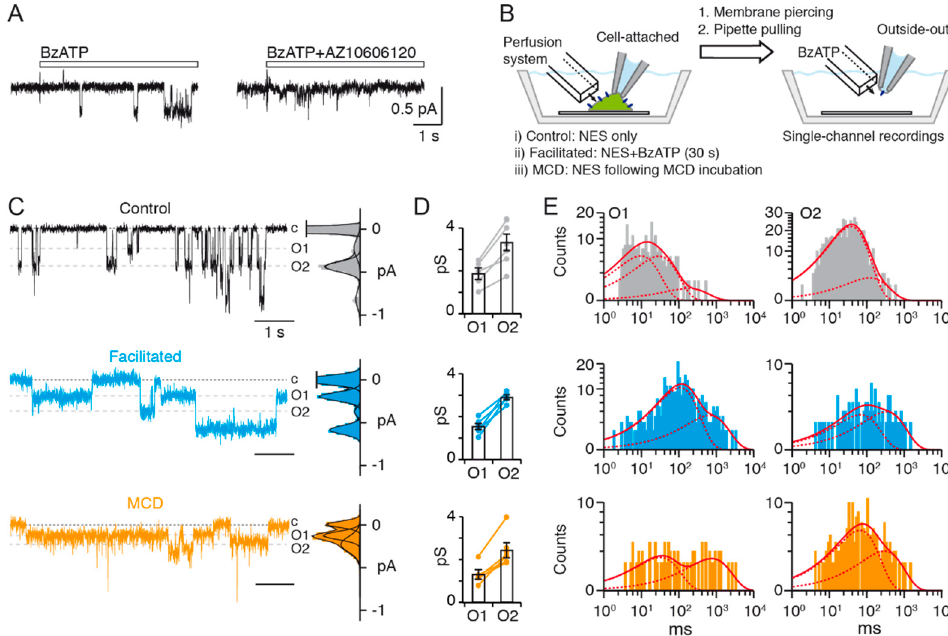
Figure 1. Current facilitation of P2X7 results in an increase of single-channel open probability. ( A ) Single-channel currents elicited by 10 µ M BzATP (duration of application indicated by the white bar) from an outside-out patch of HEK293T cell transiently transfected with rP2X7 (left) are inhibited by 1 µ M AZ10606120 when co-applied with 10 µ M BzATP (right). Traces are from the same patch and channel openings are downward deflections. ( B ) Cartoon depicting the protocol employed for establishing excised patches from cells expressing rP2X7 (blue ovals) in: (i) control conditions, (ii) facilitated conditions (10 µ M BzATP for 30 s), and (iii) MCD-treated conditions. NES: normal extracellular solution. Figure not to scale. ( C ) Single-channel currents elicited by 10 µ M BzATP from outside-out patches of HEK293T cells transiently transfected with rP2X7. Cells were either not treated (black), or pre-treated with a 30 s perfusion of 10 µ M BzATP (blue), or incubated with MCD (orange) prior to membrane excising. Dashed grey lines indicate unitary currents corresponding to conductance states O1 and O2. Dotted lines indicate basal current corresponding to closed channels, labeled c. Corresponding all points histograms of currents are shown right of the traces. Distributions were fit by a sum of Gaussians. ( D ) Summary of corresponding unitary conductances. Linking lines indicate data points that originate from the same patches ( n = 7 patches for control, 6 for facilitated and 7 for MCD-treated conditions). Bars represent mean ± SEM. ( E ) Corresponding open dwell-time histograms fitted by the sum (solid red line) of several exponential functions (dashed red lines). For control patches (grey histograms), τ 1 = 9.6 ms, relative area, a 1 = 0.49; τ 2 = 29 ms, a 2 = 0.48; τ τ τ τ 3 = 180 ms, a 3 = 0.03; mean open time, O1 = 24 ms for O1, and 1 = 38 ms, a 1 = 0.92; 2 = 119 ms, a 2 = 0.08; τ O2 = 44 ms for O2. For facilitated (blue histograms), τ 1 = 108 ms, a 1 = 0.77; τ 2 = 654 ms, a 2 = 0.23; τ O1 = 234 ms for O1 and τ 1 = 68 ms, a 1 = 0.46; τ 2 = 332 ms, a 2 = 0.54; τ O2 = 211 ms for O2. For MCD-treated patches (orange histograms), τ 1 = 32 ms, a 1 = 0.52; τ 2 = 752 ms, a 2 = 0.48; τ τ τ τ O1 = 378 ms, for O1 and 1 = 66 ms, a 1 = 0.70; 2 = 294 ms, a 2 = 0.30; O2 = 134 ms for O2. All data were recorded at − 120 mV and filtered at a final f c of 100